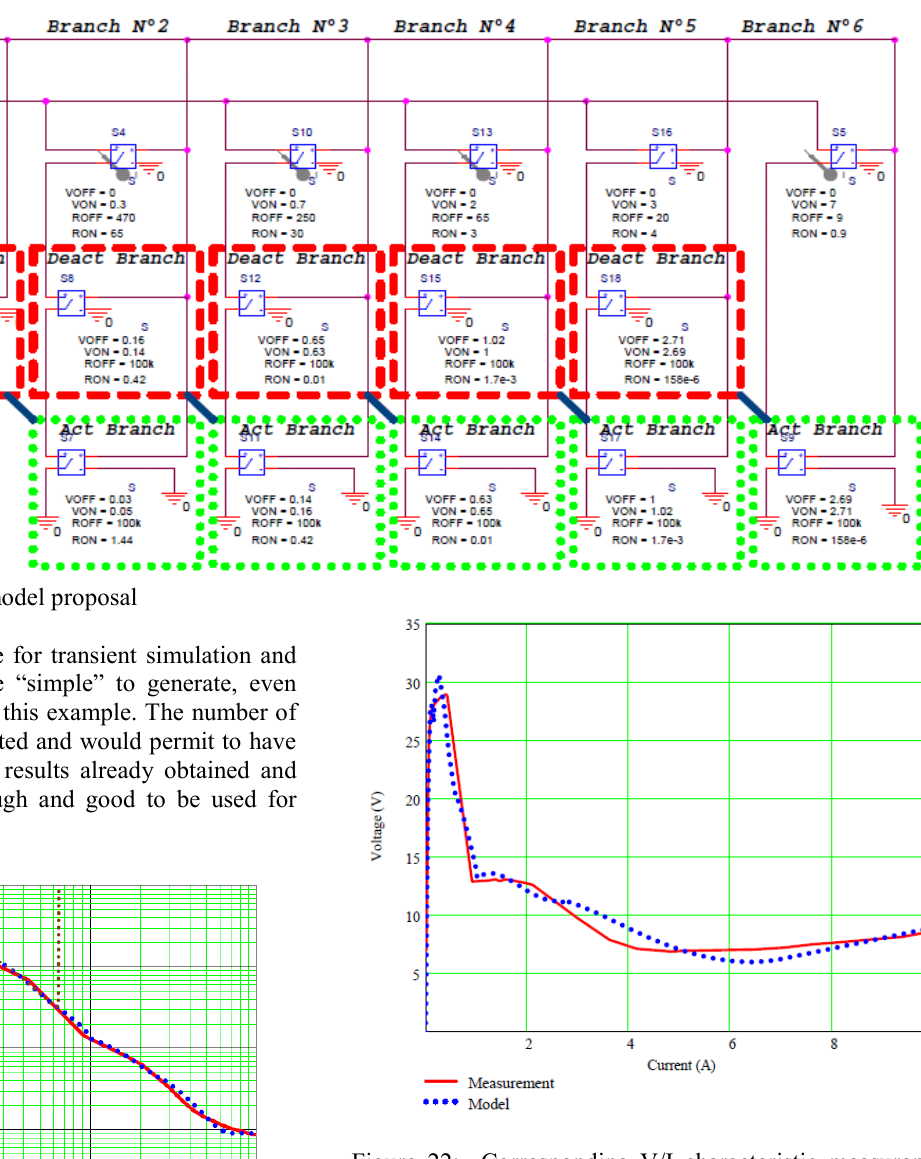
Figure 22: Corresponding V/I characteristic measurement compared to parallel “switch model” proposed